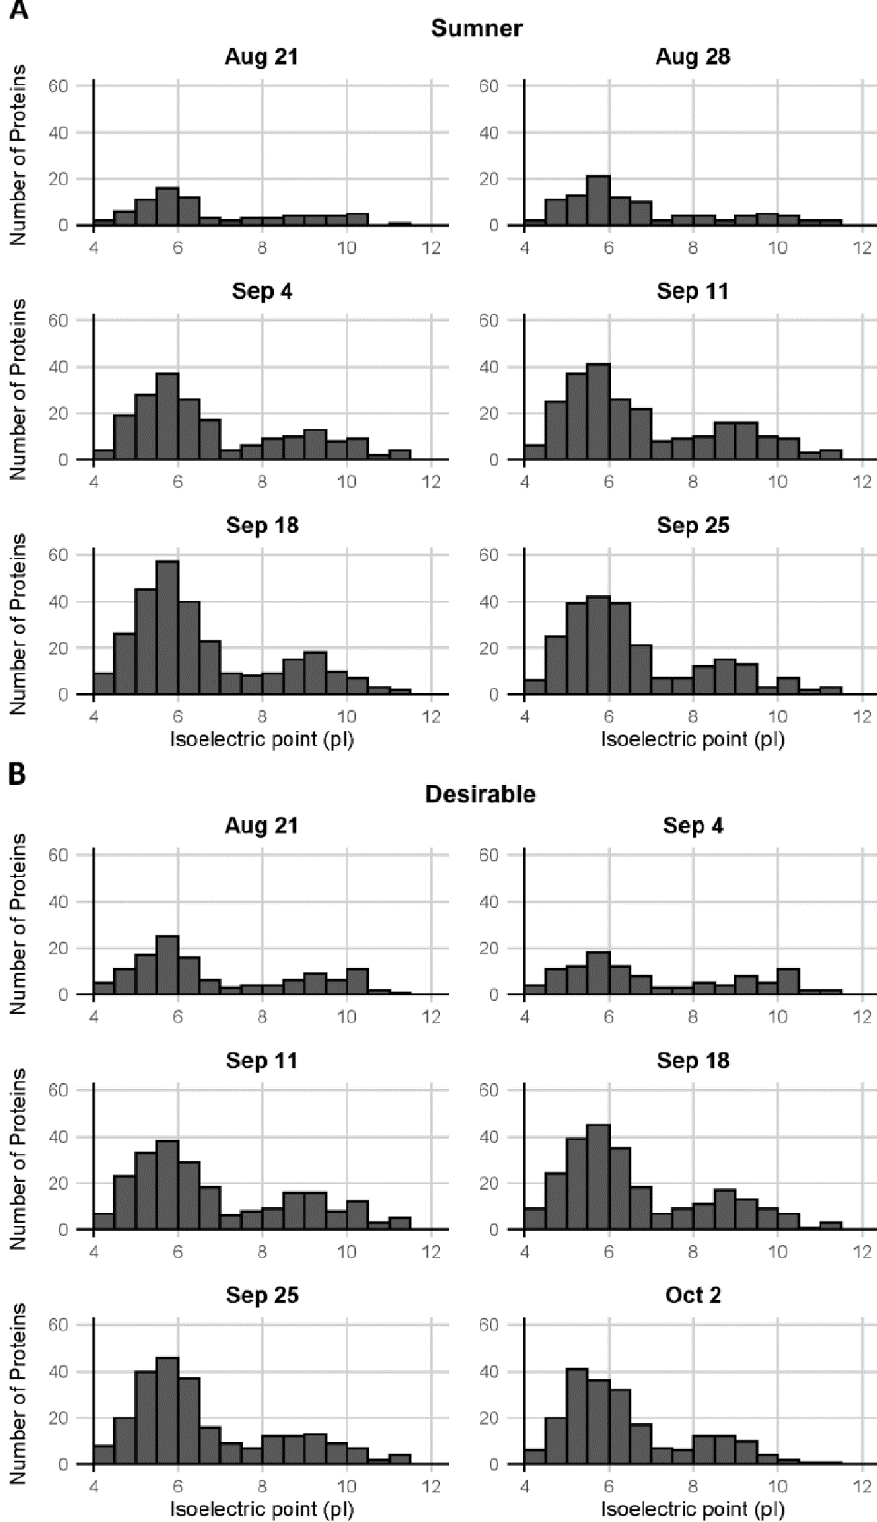
Figure 3. Distribution of isoelectric points of pecan proteins . Isoelectric points of proteins observed in ( A ) Sumner pecan nuts and ( B ) Desirable pecan nuts.